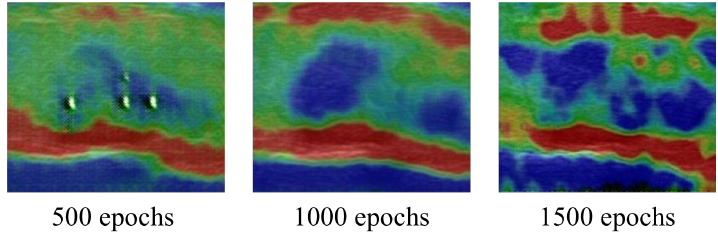
Figure 5. Generation results after 500, 1000, and 1500 epochs.